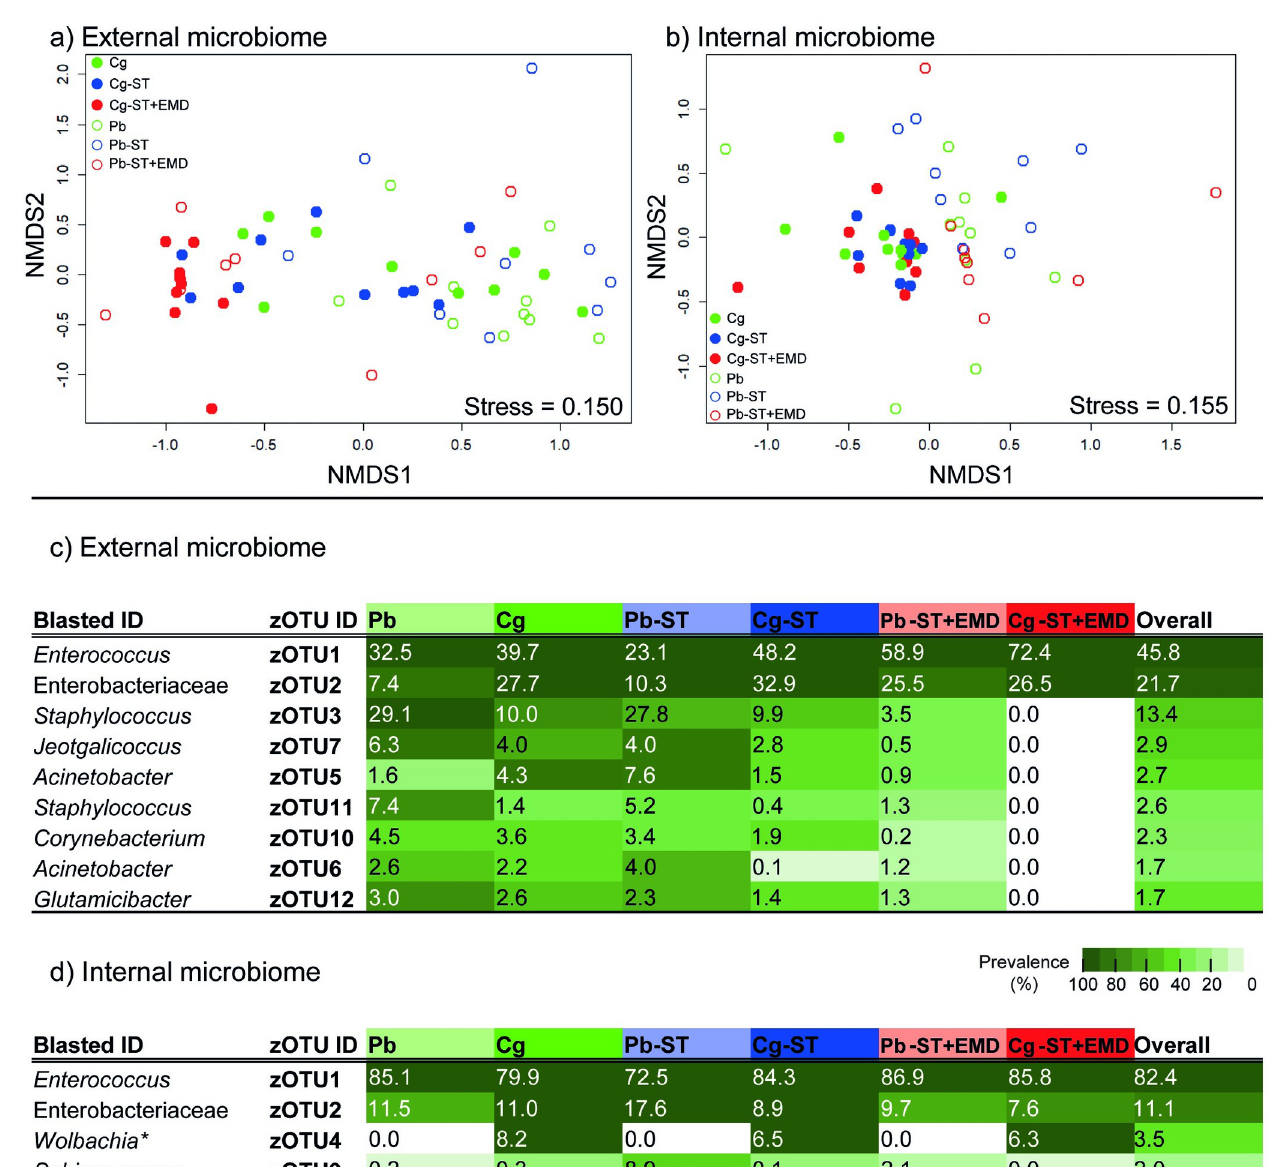
Fig 4. Overview of caterpillar-associated bacterial communities of untreated, starved or starved then external microbiome disrupted C . glomerata parasitised or unparasitised caterpillars ( P . brassicae ). a) Non-metric multidimensional scaling (NMDS) ordination plots based on Bray–Curtis distances of Hellinger-transformed relative abundance data of the external bacterial communities. b) NMDS ordination for the internal bacterial communities. c) External bacterial community profiles of the different caterpillar samples. d) Internal bacterial community profiles of the different caterpillars samples. For each zOTU, the average relative abundance (%) for each group is given in the cell as a percentage, whereas the colour indicates prevalence (white is absent). Only bacteria with an overall relative abundance > 1.5% are shown in (c) and (d). The full overview is provided as supporting information (Table B in S1 Supporting Information). zOTUs are identified by a BLAST search against type materials in GenBank. When no significant similarity was found with type materials, the BLAST analysis was performed against entire GenBank (indicated with an asterisk). Identifications were performed at genus level; when identical scores were obtained for different genera, identifications were performed at family level. Abbreviations used: Cg = untreated parasitised caterpillars; Cg-ST = starved parasitised caterpillar; Cg-ST+EMD = starved then external microbiome disrupted parasitised caterpillars. Pb = untreated unparasitised caterpillars; Pb-ST = starved unparasitised caterpillars; Pb-ST+EMD = starved then external microbiome disrupted unparasitised caterpillars.